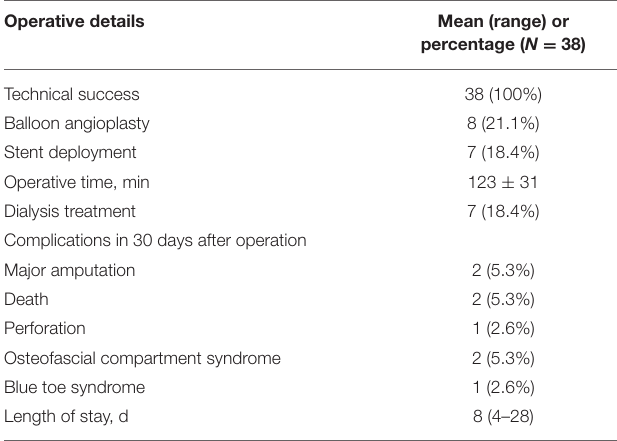
TABLE 2 | Operative